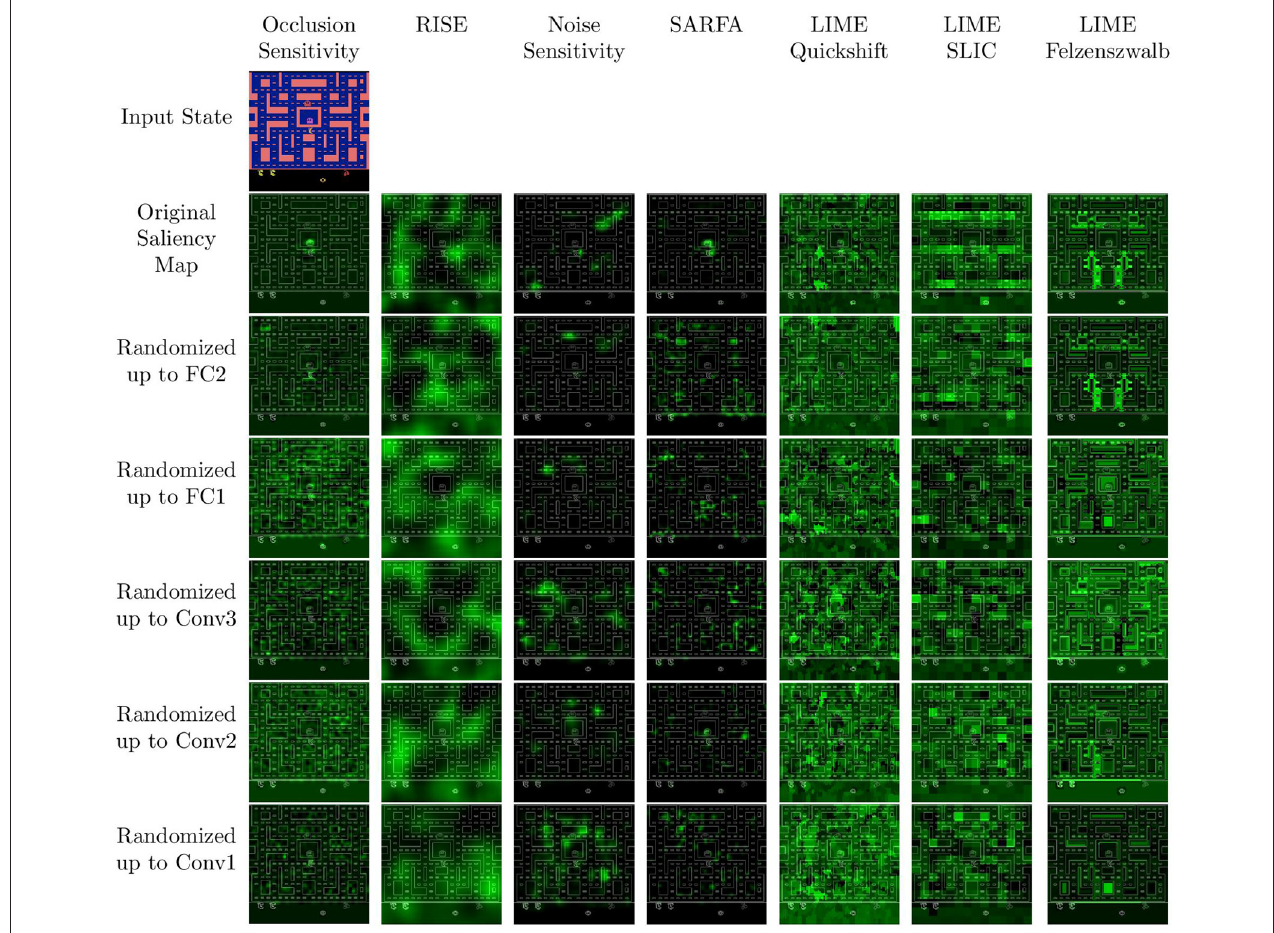
FIGURE 4 | Example saliency maps for the parameter randomization sanity check. From top to bottom each row after the first is generated for agents with cascadingly randomized layers starting with the output